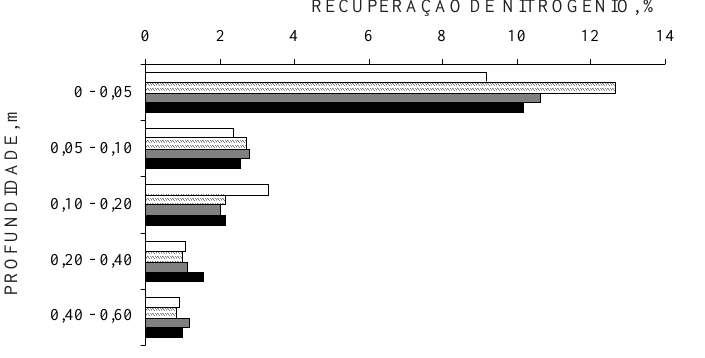
RECUPERAÇÃO DE NITROGÊNIO,